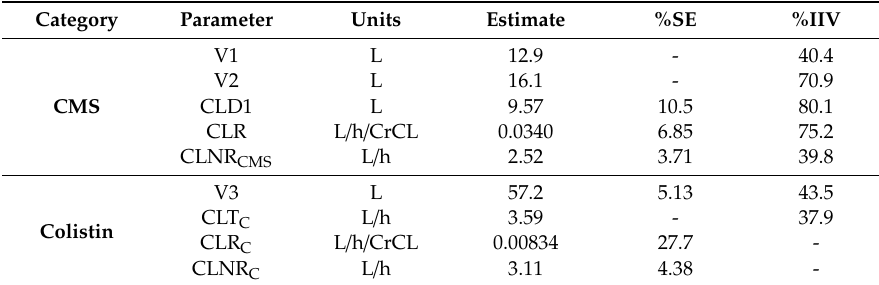
Table 1. Population pharmacokinetic parameters.